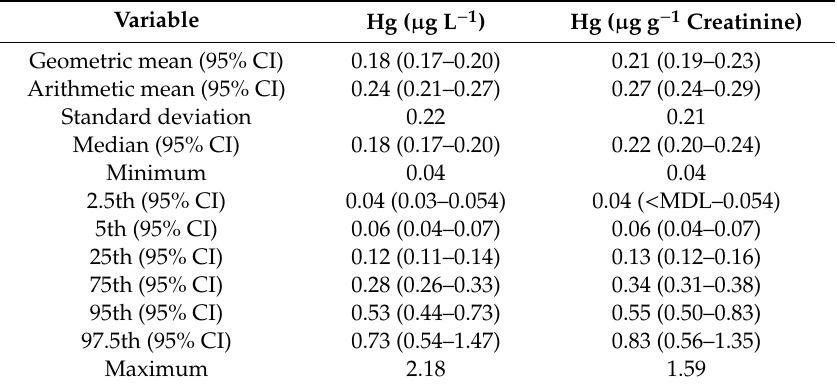
Table 2. Urinary mercury (Hg) levels of children in Italy ( n =